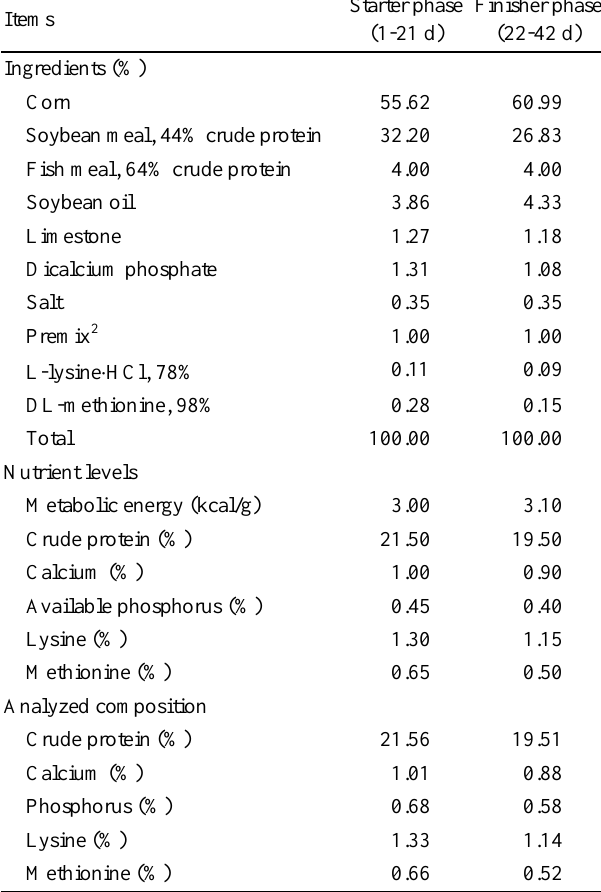
Table 1. Composition of basal diets and nutrient levels